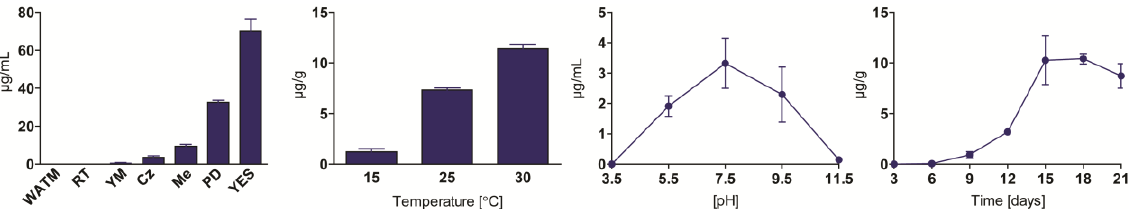
Figure 2. Production of fusaristatin by F. graminearum on seven different media, on Cz medium at pH 3.5–11.5, on YES medium after 3–days and on YES medium at 15–30